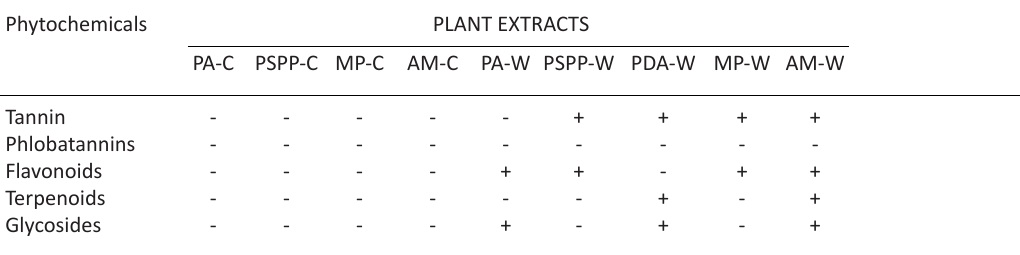
Table 1. Phytochemical screening from various qualitative biochemical tests Phytochemicals PLANT